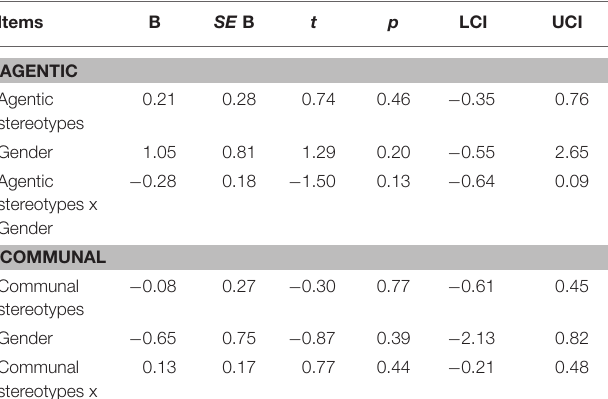
TABLE 3 | Study 1: exploratory moderated regression analysis for age